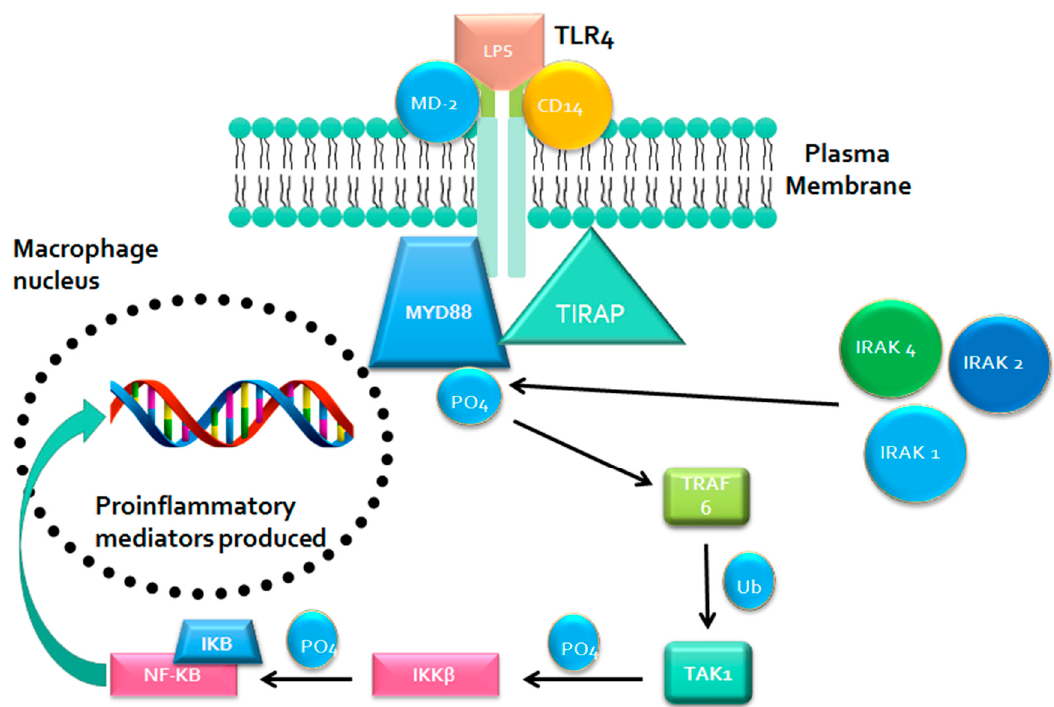
Figure 1. MYD88-mediated TLR4 signaling pathway results in the production of pro-inflammatory cytokines. Activation of TLR4 by LPS through MYD88 dependent pathway results in activation and nuclear translocation of NF- κ B which upregulates production of pro-inflammatory cytokines and chemokines. Abbreviations: MYD88 - myeloid differentiation primary response gene 88, TLR4—Toll